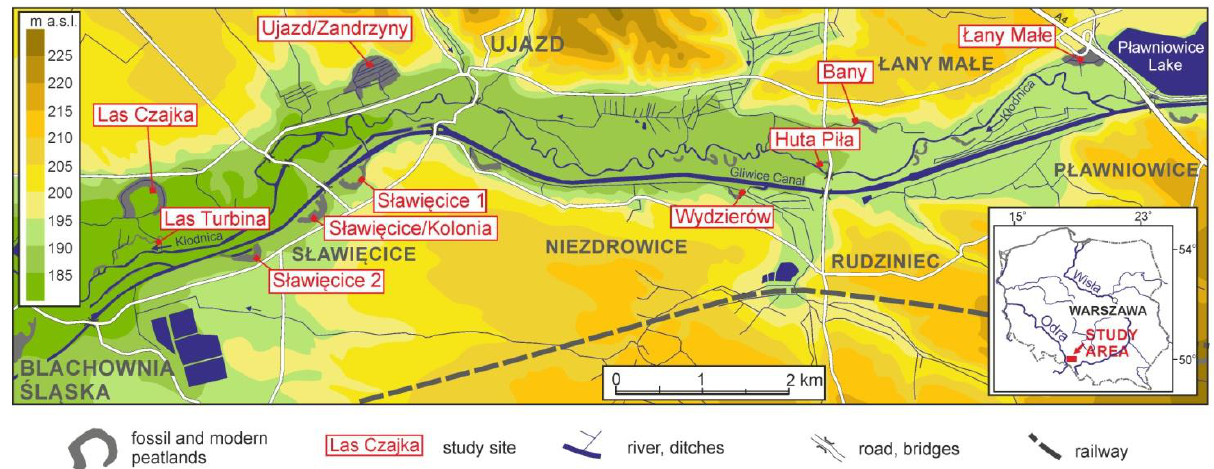
Fig. 1. Location of peatlands and study sites in the lower Kłodnica valley between Blachownia Śląska and